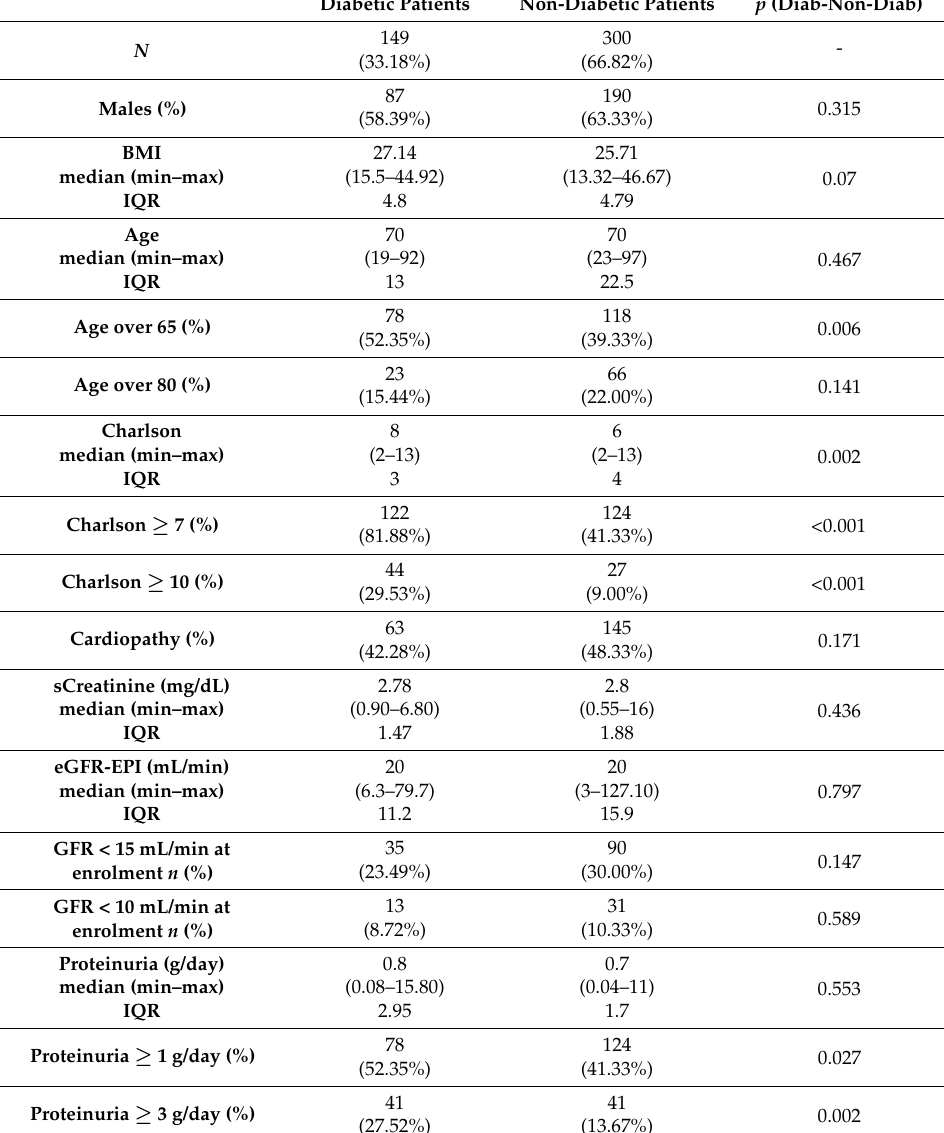
Table 2. Baseline Characteristics of the diabetic and non-diabetic Chronic Kidney Disease (CKD) populations